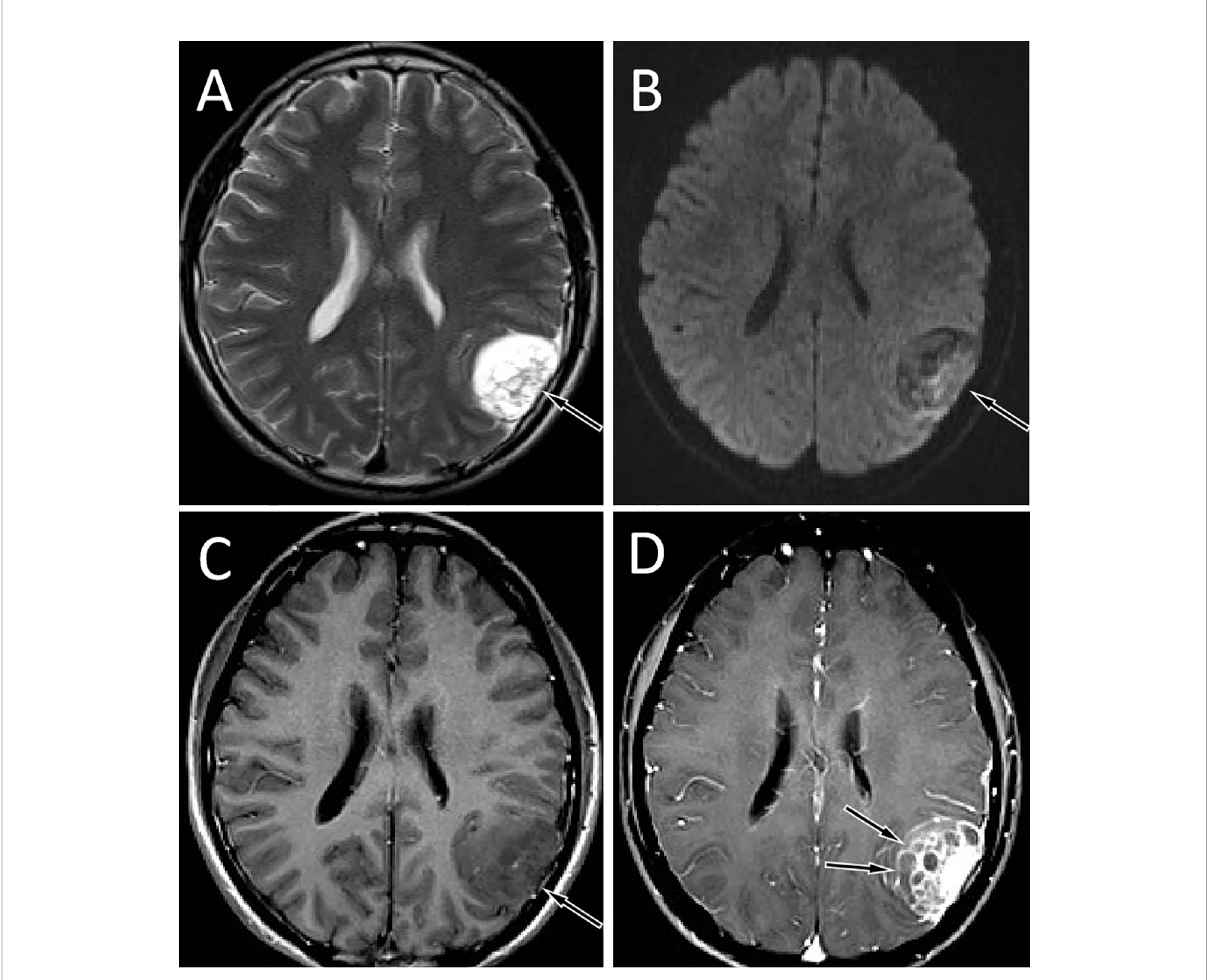
FIGURE 1 Brain MRI showed that the tumor was located in the left temporo-occipital fossa. T2WI sequence showed that the lesion was high signal ( A , arrow). Diffusion-weighted imaging showed that the movement of water molecules was not restricted and showed heterogeneous low signal ( B , arrow). The T1WI sequence showed that the lesion was slightly low signal ( C , arrow), and the solid component of the tumor was signi fi cantly enhanced on contrast-enhanced T1WI, with multiple unenhanced cysts around it, and septum-like enhancement was seen in between ( D,